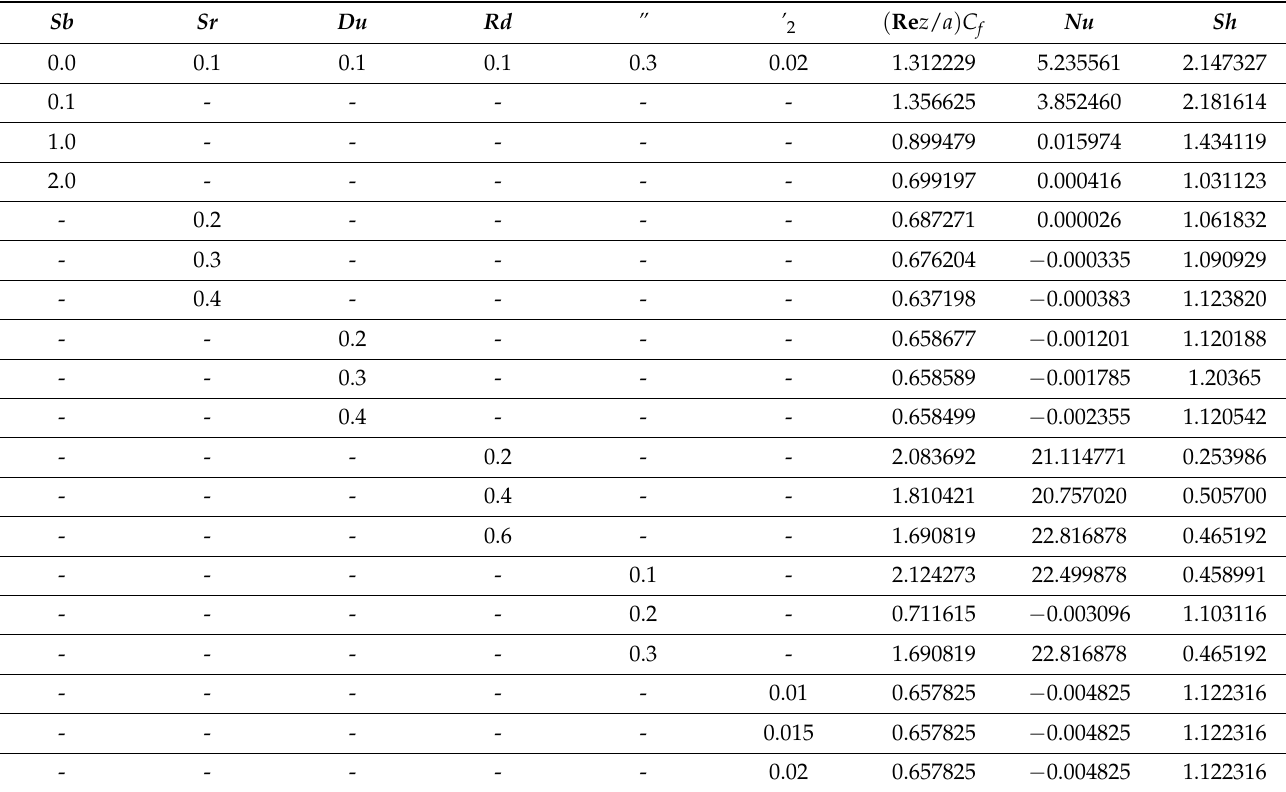
Table 5. Numerical values of ( Re z / a ) C f , Nu and Sh when Pr = 6.2, Re = 1 and ϕ 1 =